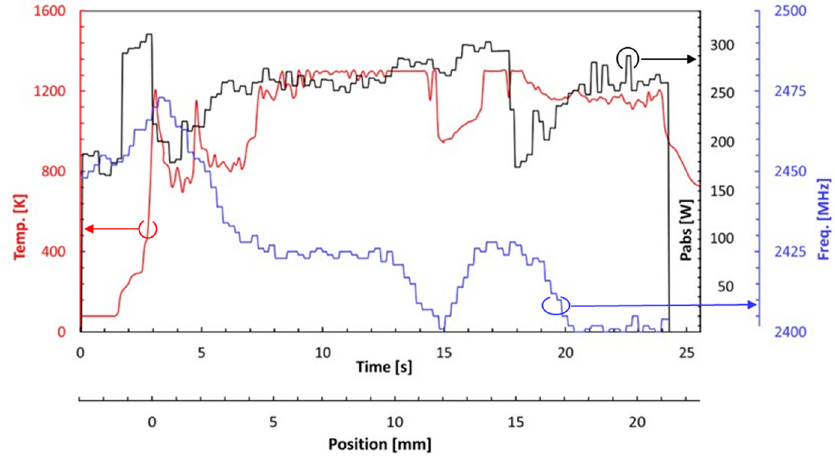
Figure 4. Measurements during a typical LMH scanning process, including the absorbed microwave power (in black), the frequency variation for the adaptive impedance matching (in blue), and the temperature that evolved along the scanned powder surface (in red; note that the thermal runaway instability is detected after ~3 s of microwave irradiation).